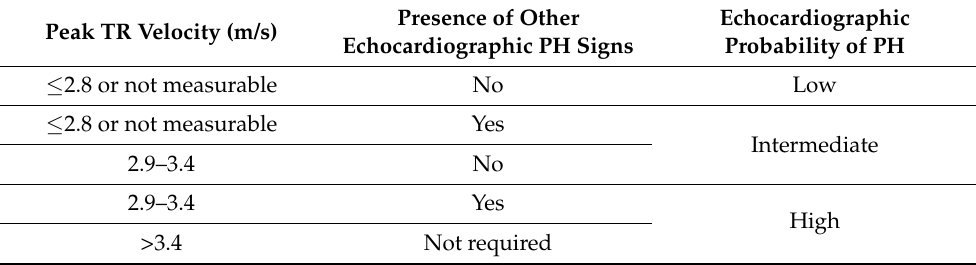
Table 3. Echocardiographic assessment of PH probability. Modified after [7]. Legend: TR–tricuspid regurgitation, PH–pulmonary hypertension. See Table 4 for supplementary echocardiographic signs.